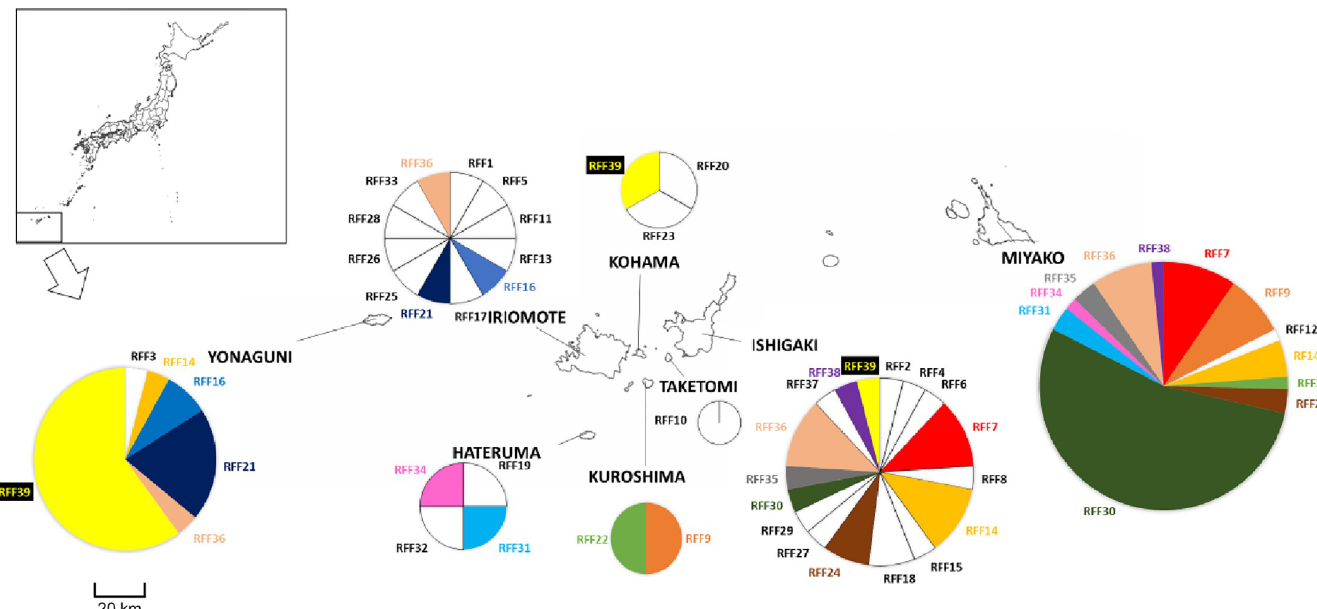
Fig 1. mtDNA haplotype distribution. Ratio of the number of samples of each haplotype is shown for each island on the map. The sizes of circles represent the sample sizes. Haplotypes shared between islands are shown with the same colors. Source of the map was the Geospatial Information Authority of Japan